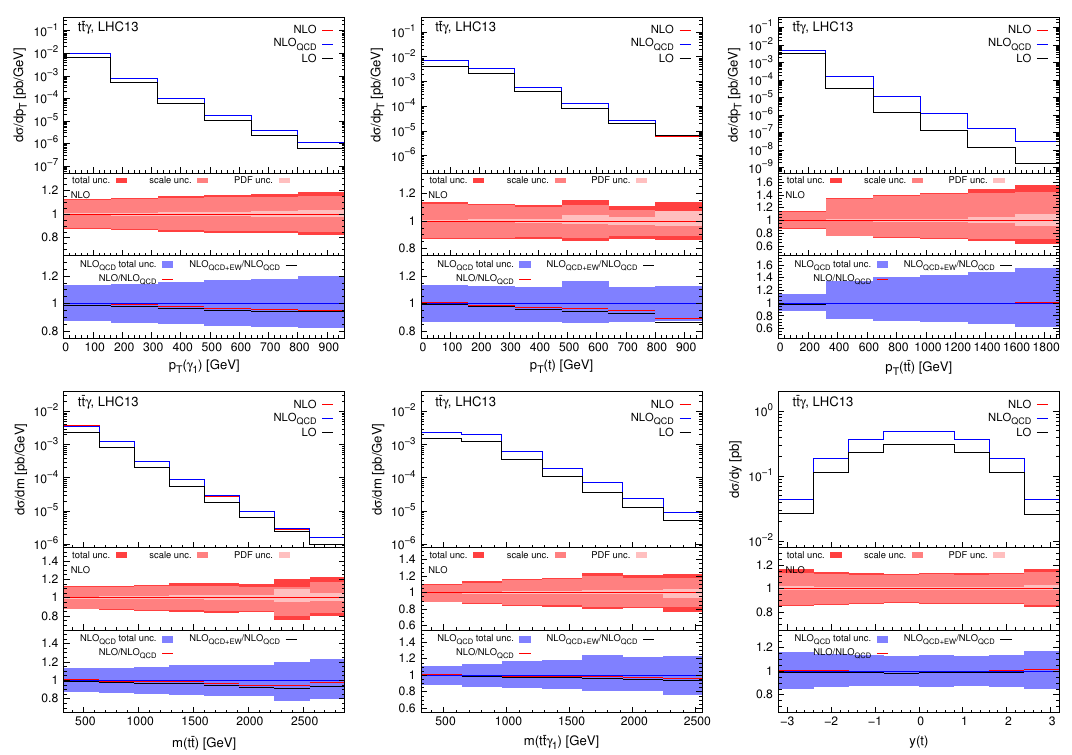
Figure 1 . Differential distributions for t ¯ tγ